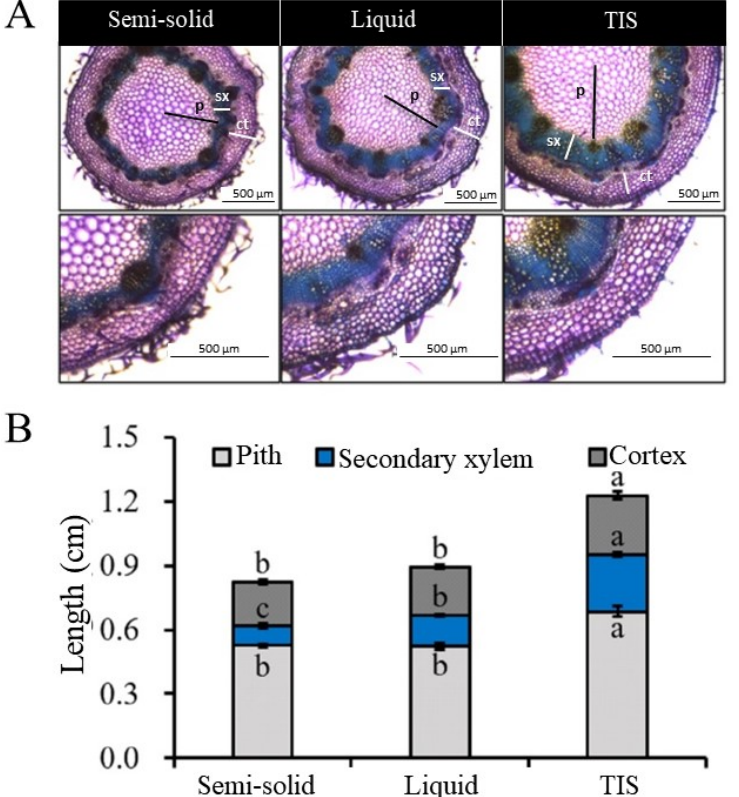
Figure 5. Histological analysis of chrysanthemum plants grown using semi-solid, liquid, and TIS cultures. ( A ) Histological observation of chrysanthemum stems in semi-solid, liquid and TIS cultures (p: pith, sx: secondary xylem, ct: cortex). ( B ) Stem diameter of chrysanthemum plants in semi-solid, liquid and TIS cultures. Different letters differ significantly from each other by Duncan’s multiple-range test (DMRT; p ≤ 0.05).